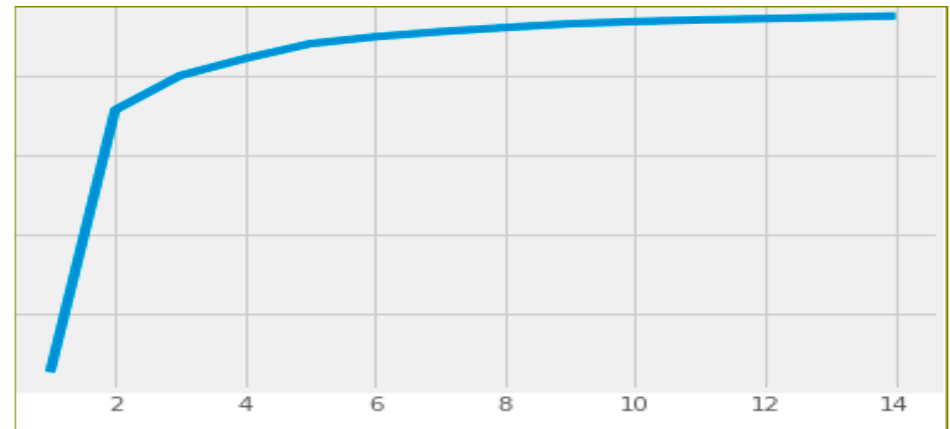
Figure 11. Number of Clusters.